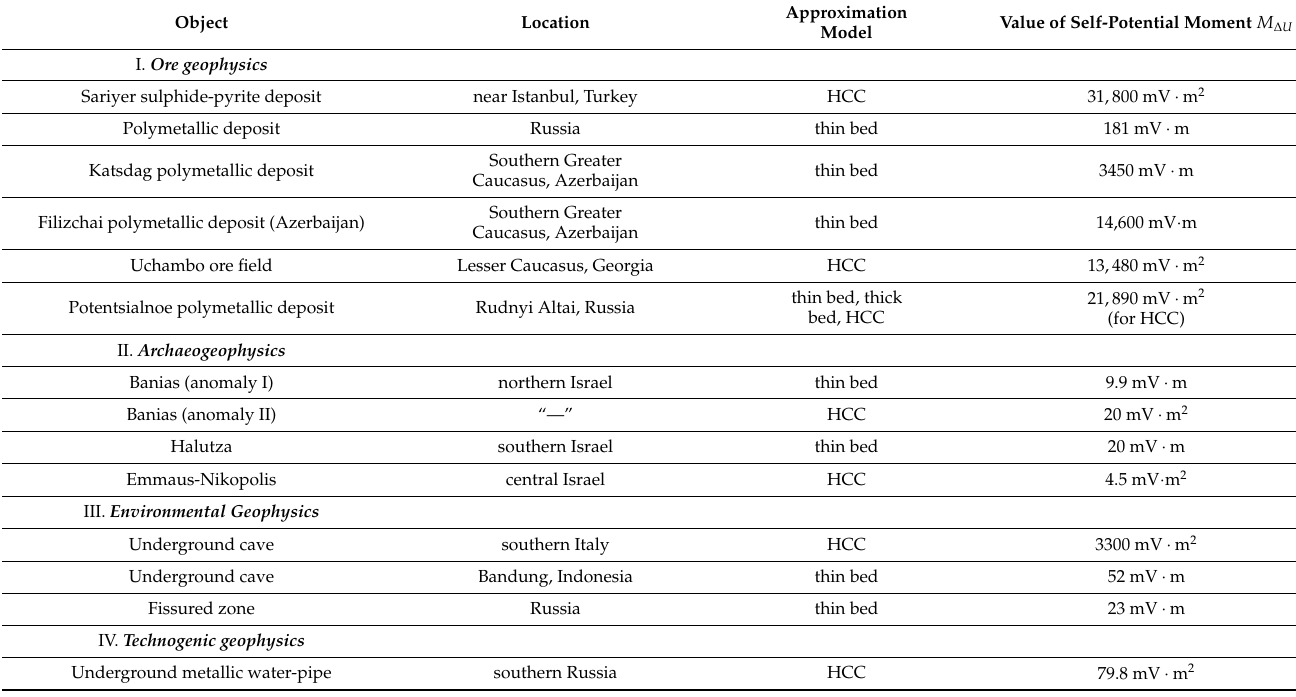
Table 5. Comparison of self-potential moments calculated from different anomalous targets (considered in Sections 5.2–5.5).